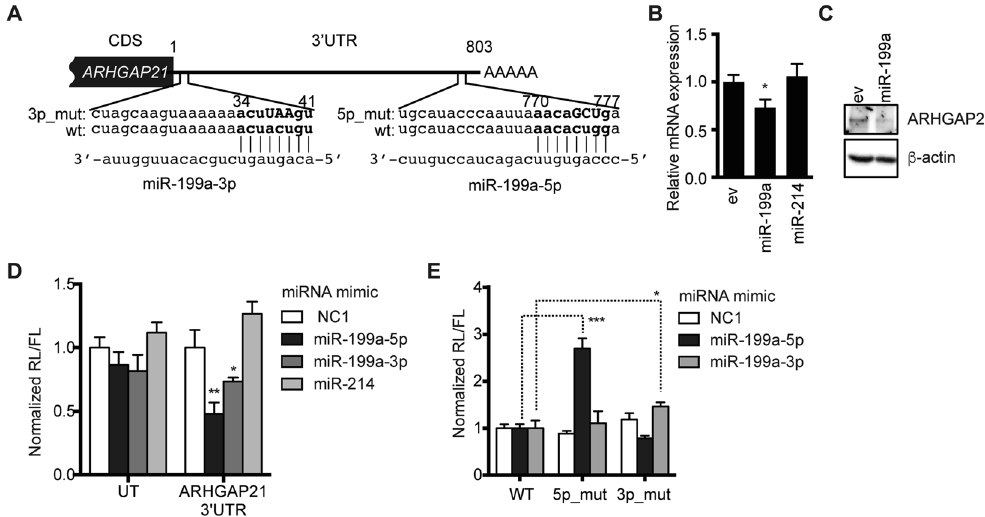
Figure 3. ARHGAP21 is a target of both miR-199a-5p and -3p. ( A ) Schematic diagram of the binding sites of miR-199a-5p and -3p within the 3 ′ UTR of ARHGAP21 mRNA (wt) and mutated sequences (3p_mut and 5p_mut). Sequences of seed sites are indicated in boldface and mutated bases in uppercase. ( B ) qRT-PCR analysis of ARHGAP21 mRNA in A549 cells transduced with control (ev) or pre-miRNA-expressing lentiviral vector. GAPDH was used as an internal control. ( C ) Western blot analysis of ARHGAP21 and β -actin in A549 cells transduced with control or miR-199a-expressing lentiviral vector. ( D ) Expression of firefly luciferase genes containing the 3 ′ UTR of ARHGAP21 mRNA or an untargeted (UT) sequence, measured in the presence of an miRNA mimic. (E) Expression of firefly luciferase genes containing the 3 ′ UTR of ARHGAP21 mRNA (WT) or its mutants (5p_mut or 3p_mut), whose sequences are shown in ( A ), measured in the presence of an miRNA mimic. In ( B–E ), the data represent the means ± s.d. ( n = 3). Asterisks indicate the p value ( t -test) compared with the control (EV in A and NC1 in D ) or with the wild-type 3 ′ UTR of ARHGAP21 ( E ). * p < 0.05, ** p < 0.01, *** p <